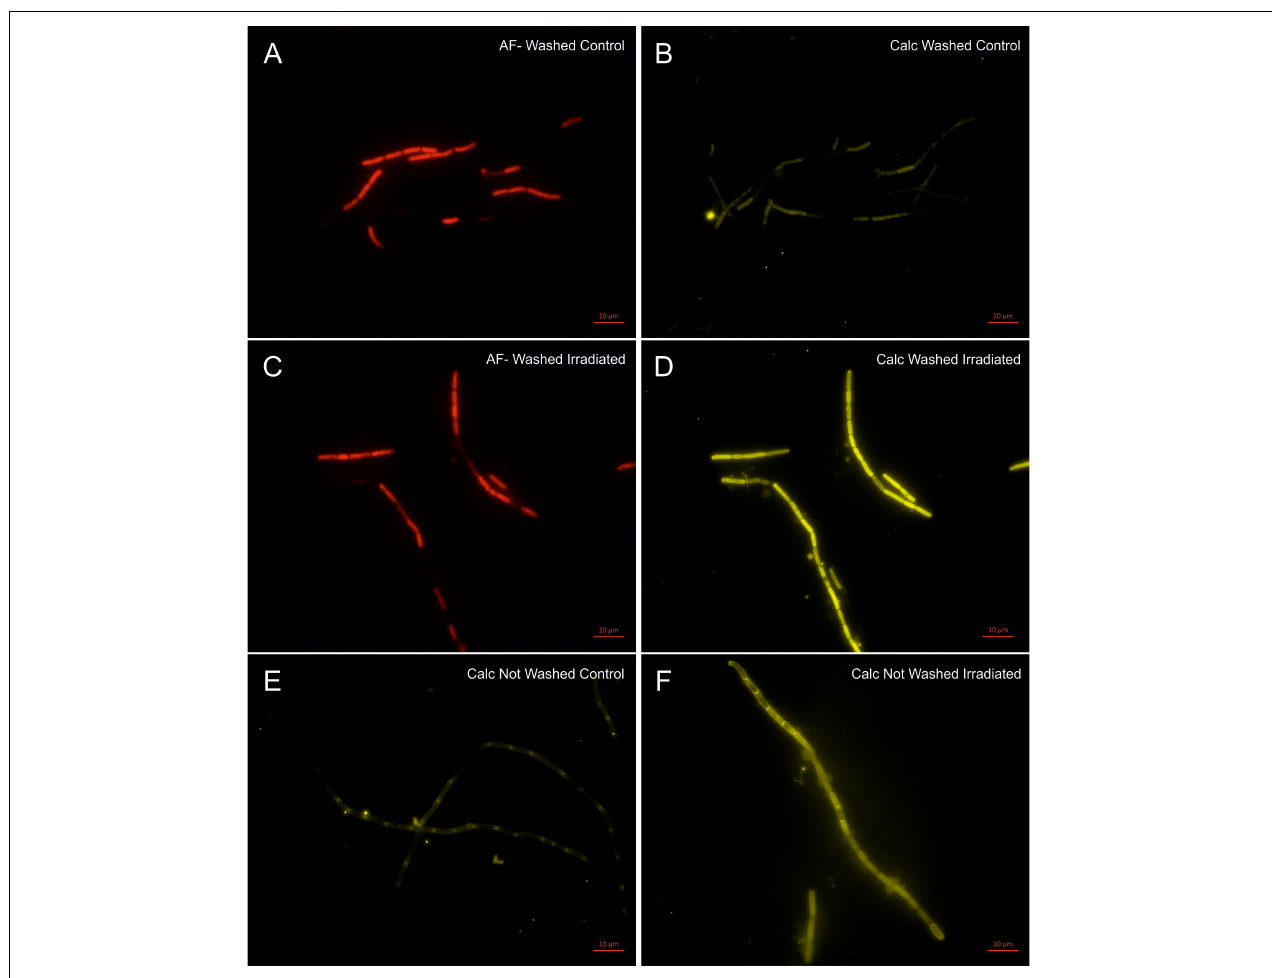
FIGURE 6 | Light microscopy of P. catenata filaments at day 16: A–D were washed twice with normal saline [0.9 g L - 1 NaCl] (A) auto-fluorescence of control culture; (B) calcofluor white stained control culture; (C) auto-fluorescence of irradiated culture; (D) calcofluor white stained irradiated culture; (E) calcofluor white stained unwashed control culture; and (F) calcofluor white stained unwashed irradiated culture. Scale bar denotes 10 µ